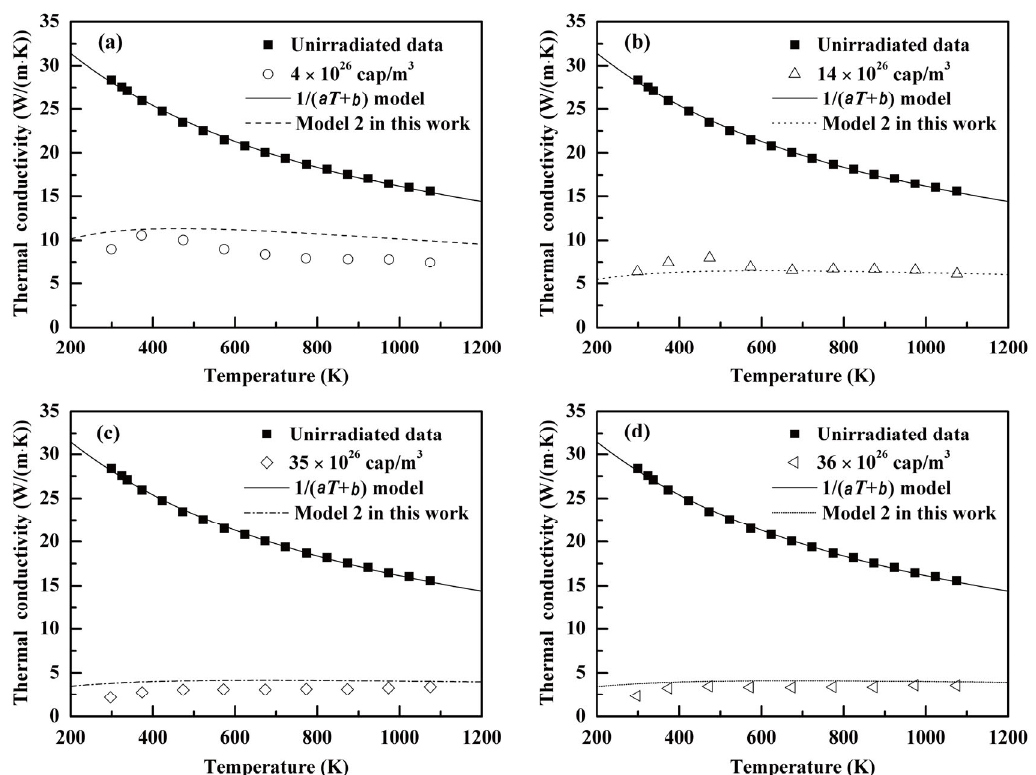
Fig. 3 Predicted thermal conductivities at different burnups by the model considering both the contributions of the substitutional defects and Frenkel defect pairs (Model 2) with comparison to the experimental data of the samples before and after irradiation by Maruyama et al .